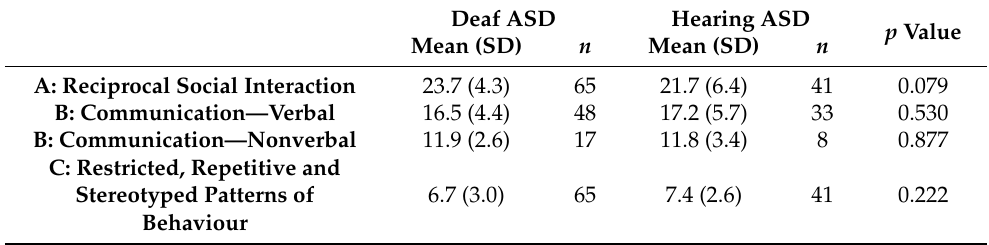
Table 2. Mean scores for ADI-R Deaf Adaptation Algorithm Domains by Diagnostic Group.